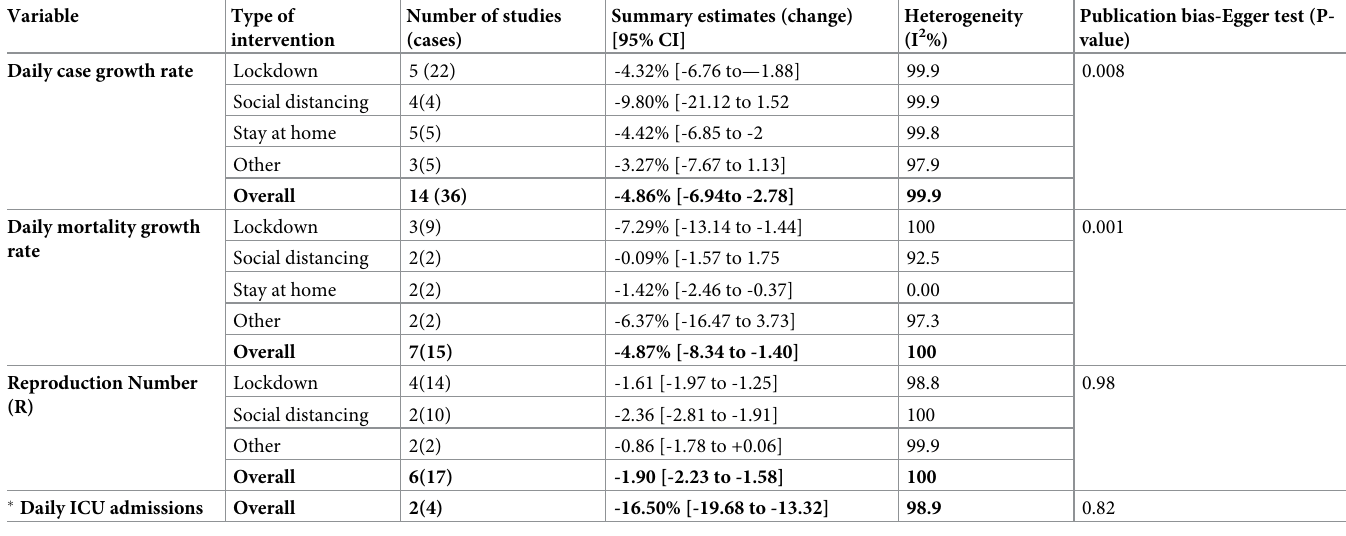
Table 1. Results of the meta-analysis, heterogeneity analysis, and publication bias